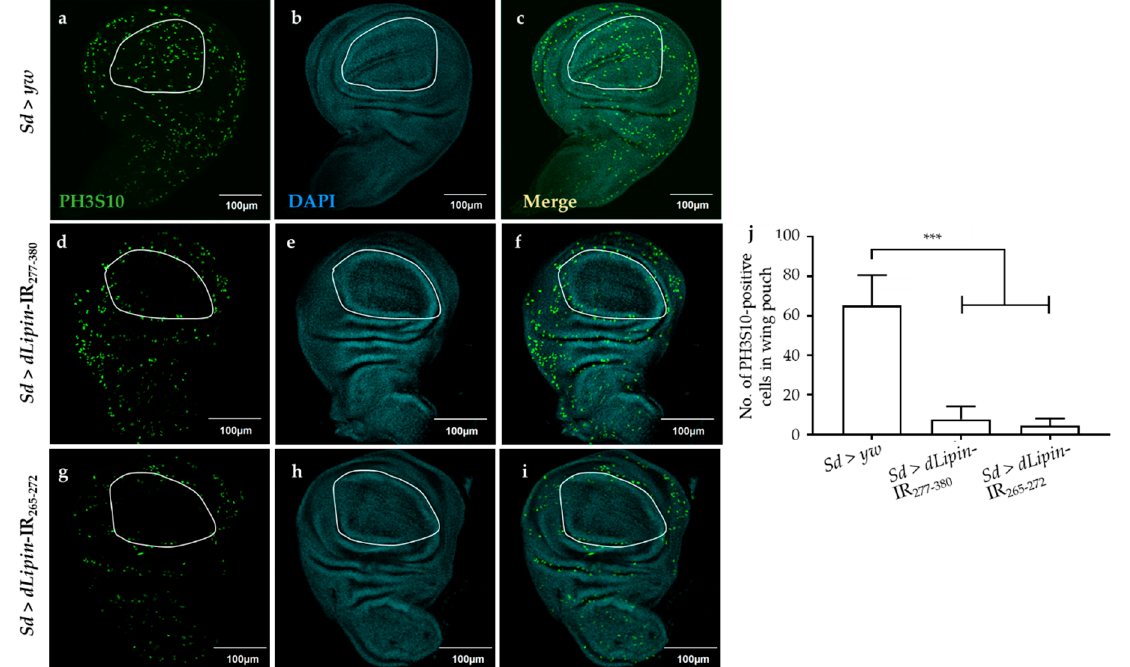
Figure 4. Knockdown of dLipin leads to a reduced number of mitotic cells in wing pouch. The wing imaginal discs from 3rd-instar larvae of control ( Sd > yw ) and dLipin- kd flies ( Sd > dLipin -IR 265-272 , Sd > dLipin -IR 277-380 ) were stained with DAPI to visualize the DNA ( b, e, h ) and anti-PH3S10 antibody followed by anti-rabbit IgG Alexa Fluor TM 488 antibody ( a, d, g ). Merged images of DAPI and PH3S10 antibody staining are shown ( c, f, i ). PH3S10-positive cells (mitotic cells) in the wing pouch of 3rd-instar larvae were counted using MetaMorph software ( n = 10 for each genotype) ( j ). Dotted line indicates the wing pouch of the wing imaginal disc. Data are expressed as the means ± S.D. The statistical significance of the difference between control and dLipin- kd flies was evaluated using one-way ANOVA. ***, p < 0.01; Scale bar, 100 µm; IR, inverted repeat. Genotypes: Sd -GAL4/+; +; + ( a – c ), Sd -GAL4/+; UAS -dLipin- IR 277-380 /+; + ( d – f ), Sd -GAL4/+; UAS -dLipin- IR 265-272 /+; + ( g – i ).